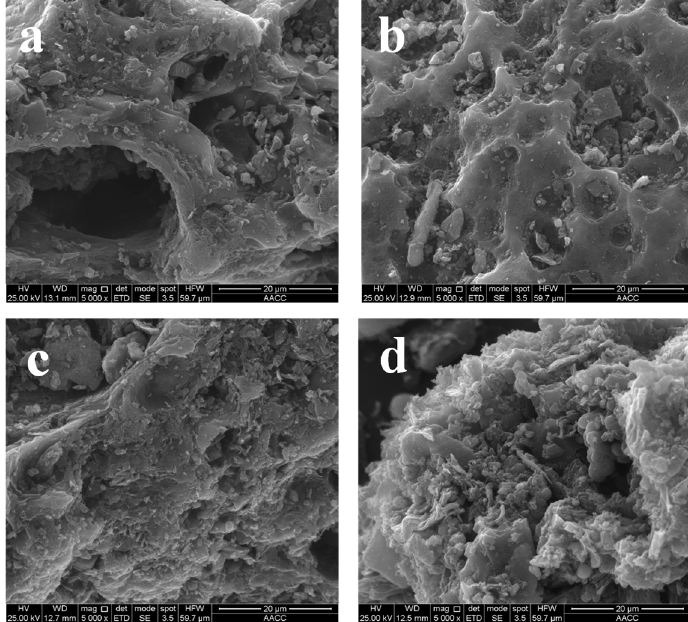
Figure 10. Surface morphology of reused coke powder. ( a ) Reused once, ( b ) reused three times, ( c ) reused five times, and ( d ) reused nine times.